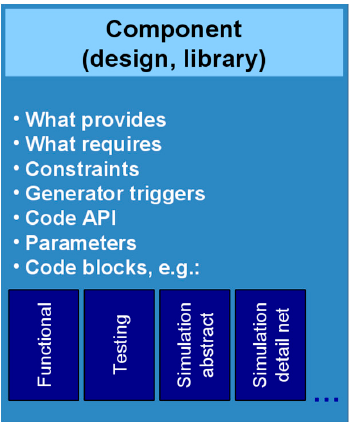
Figure 11. Top-level application specification component and library component structure includes different views (darker on the bottom and handled as black boxes by the synthesis engine) and metadata expressing component requirements and capabilities.